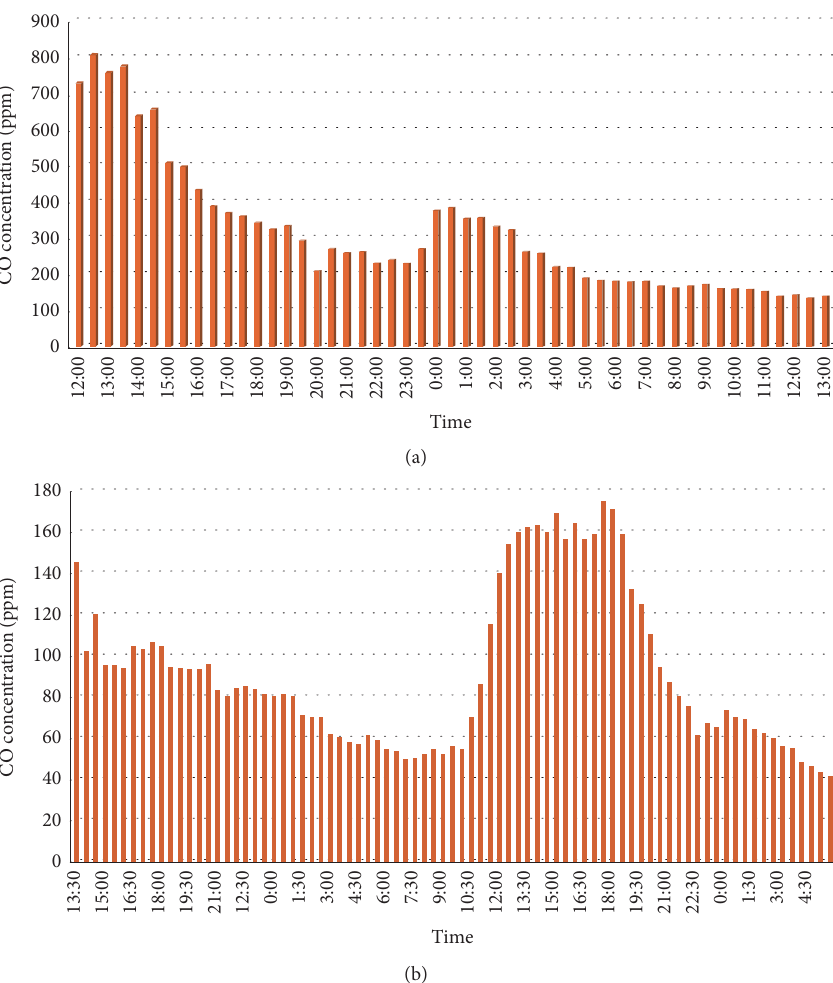
Figure 19: Variation of CO concentration during the first (top) and second (bottom)